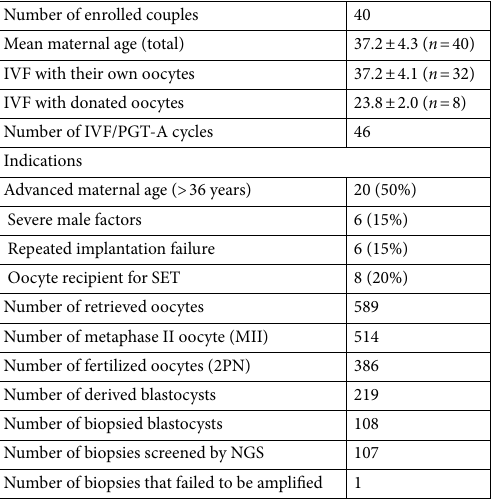
Table 1. Patient profile. 2PN, 2 pronuclei; NGS, next-generation sequencing; SET, single embryo